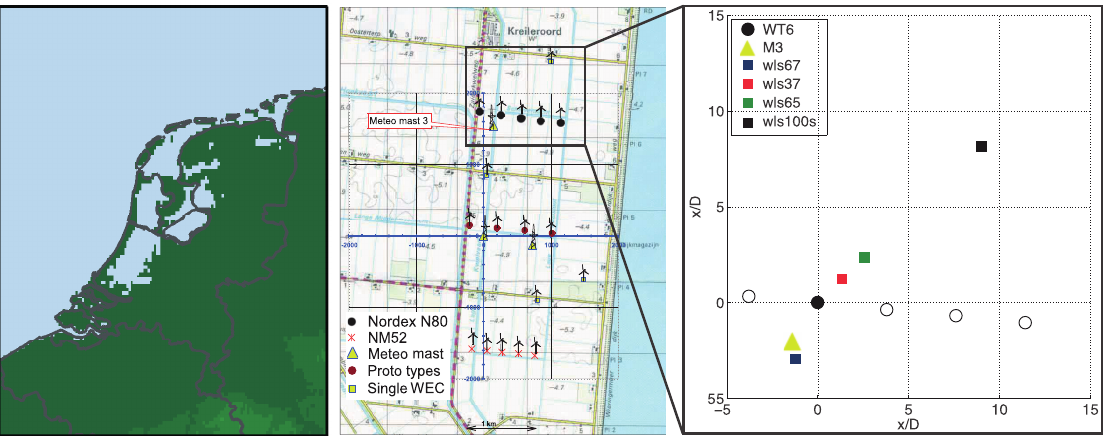
Figure 1. Map of the Netherlands with the location of the wind turbine test site Wieringermeer and the measurement setup. Blue, green and red squares and the yellow triangle indicate the location of the Windcube v1 and the met-mast relative to the research turbine WT6 illustrated by a full circle. Open circles show the rest of the research